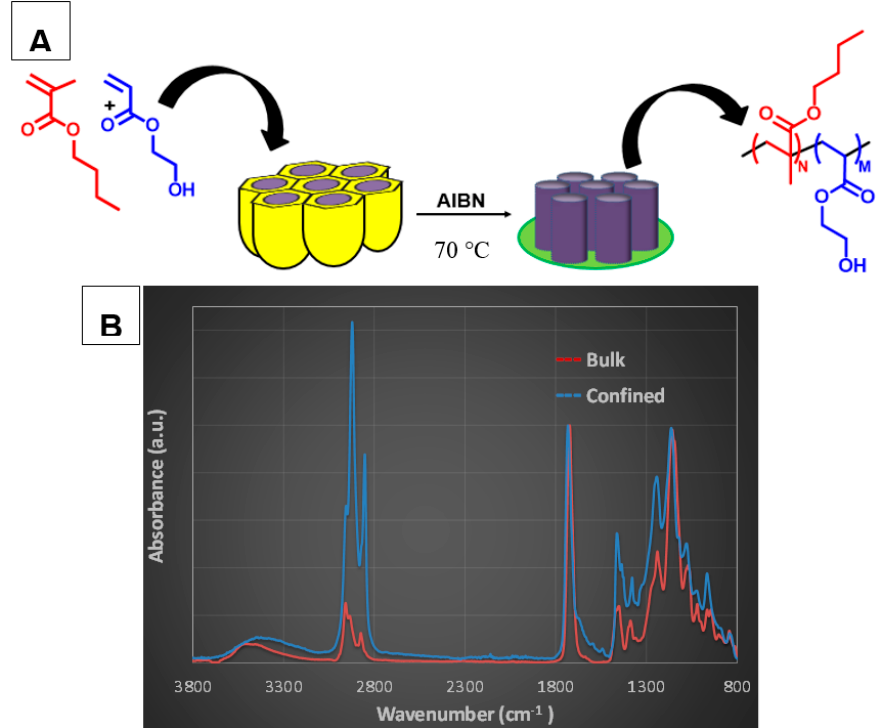
Figure 2 . ( A ) Schematic copolymerization procedure of BMA and HEA monomers under confinement, and monomers and copolymer structures. ( B ) Infrared spectroscopy (IR) spectra of the copolymers obtained under confinement and in bulk conditions.